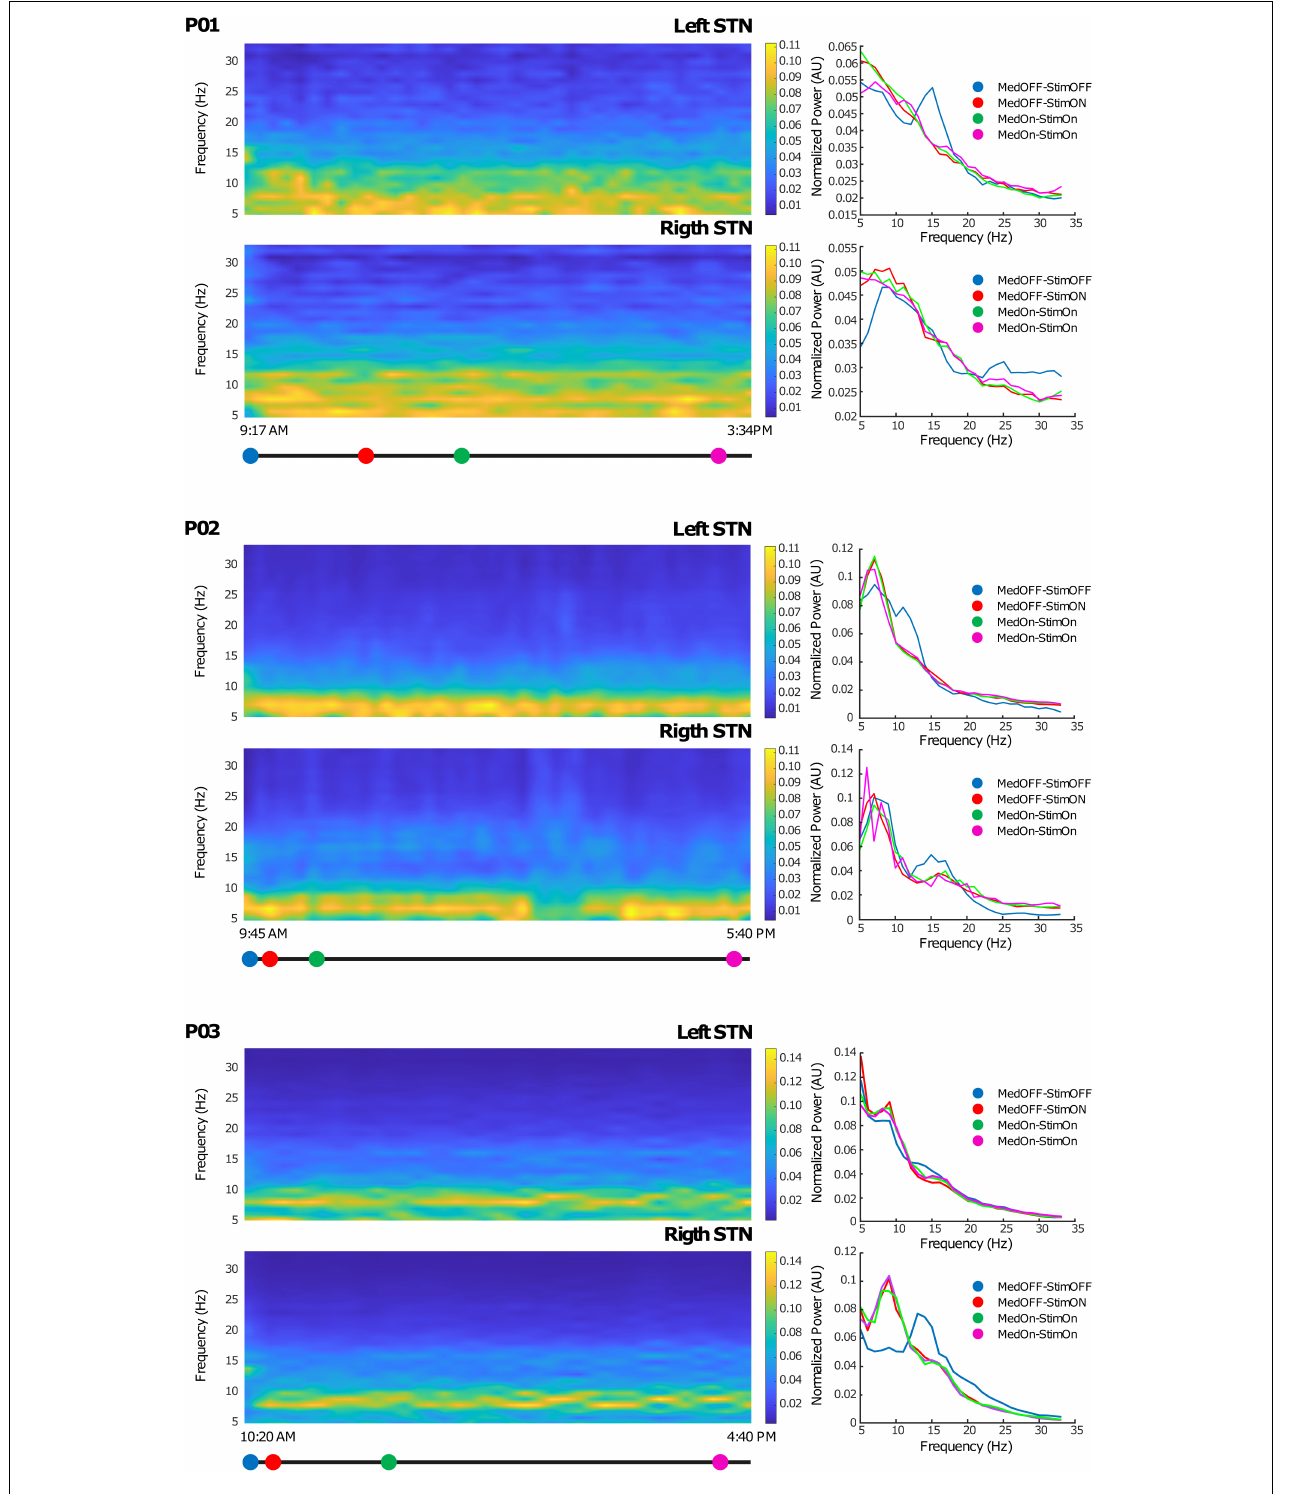
FIGURE 4 | Chronic LFP recordings in the embedded mode: Left side: Time-frequency plots of six representative hours. The x-axis represents time and the y-axis frequency (from 5 to 35 Hz). The colored dots (blue, red, green, and magenta) correspond to clinical evaluations at MedOFF/StimOFF, MedOFF/StimON, MedON/StimON, and MedON/StimON, respectively. Right side: Amplitude spectrum of the LFPs of both the left and right STN extracted as the mean of the ± 10-min interval around the evaluation point (MedOFF/StimOFF, MedOFF/StimON, MedON/StimON, and MedON/StimON) obtained at the time indicated in the left side panels. Please note that, in MedOFF-StimOFF, a clear beta peak is present in the left STN of patients 01 and 02 and the right STN of patient 03. This beta peak was disappeared by the stimulation.